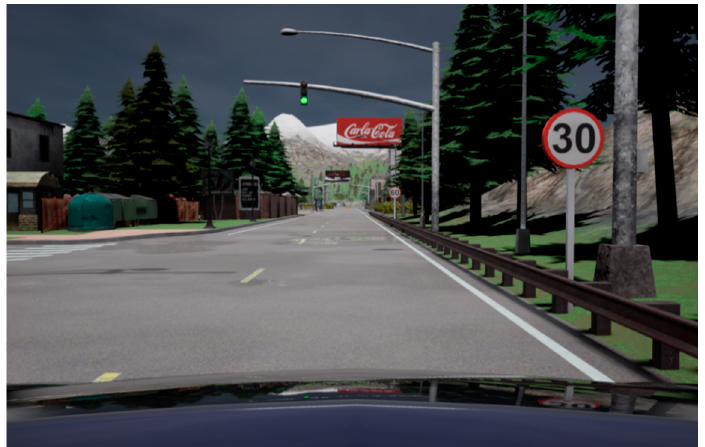
Figure 6. Sample image from video used in experiment with two speed limit signs visible.